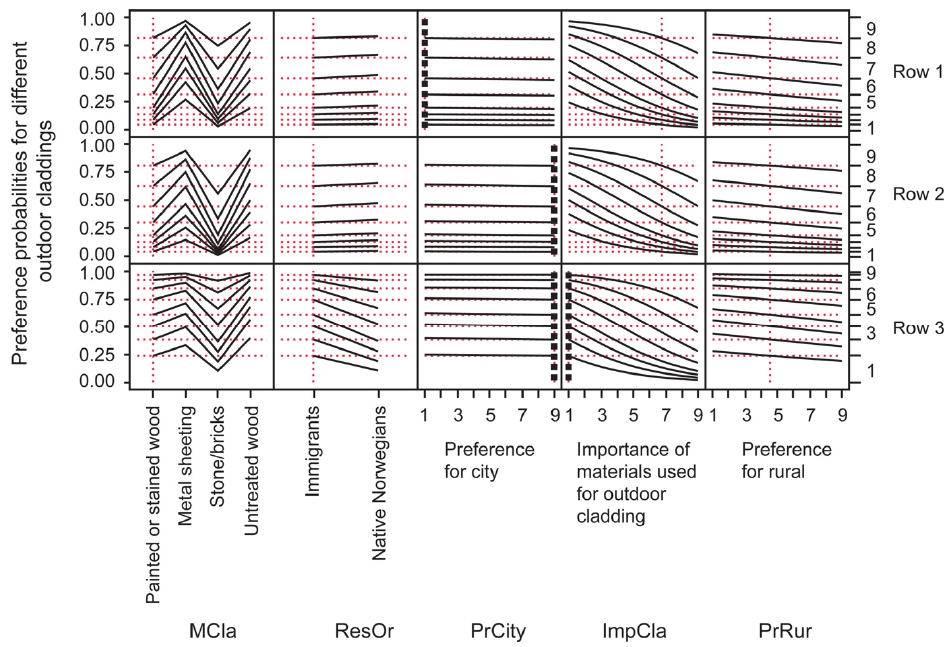
Figure 4. Profile plots showing the preferences for different outdoor cladding materials, which depend on the values of the different independent variables in Model 2. Three rows of plots are included in the figure to show how the preferences for the different outdoor cladding materials change with differing settings of the independent variables. This figure text is partly the same as that in Figure 4 in the article of Høibø et al. [21].